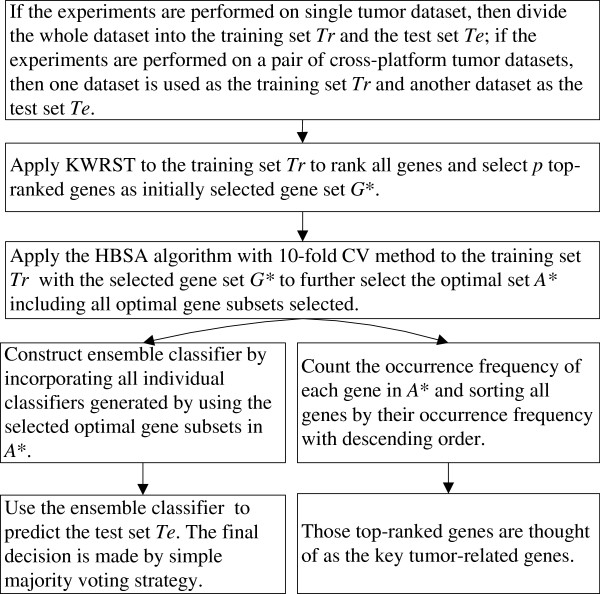
The flowchart of our analysis method.